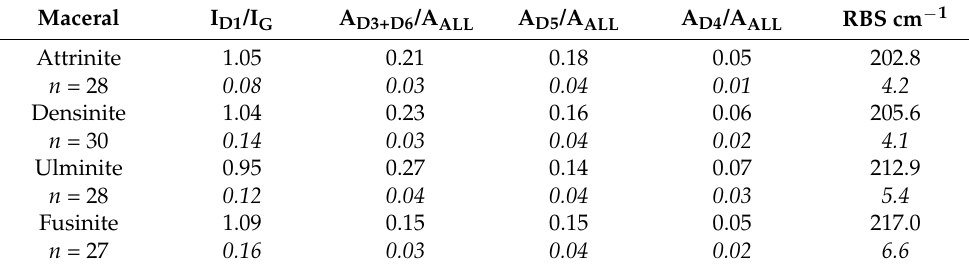
Table 5. Spectral ratios and Raman Band Separation (RBS) derived from the curve fitting